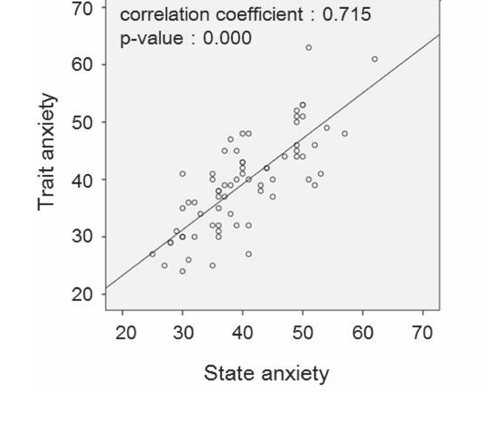
figure 2 - Correlations of trait anxiety with state anxiety, PCS, and MCS are shown (Spearman’s rank correlation coefficient) (A, B, C). Trait anxiety was strongly correlated to state anxiety. In addition, the correlation of trait anxiety with MCS was stronger than that with